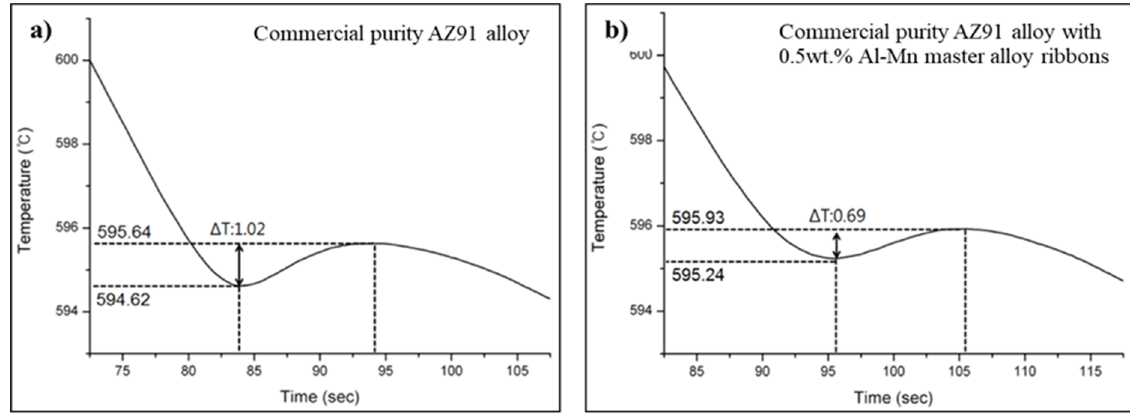
Figure 11. Typical cooling curves of ( a ) CP AZ91 alloy and ( b ) CP AZ91 alloy with 0.5 wt.% Al–Mn master alloy ribbons.